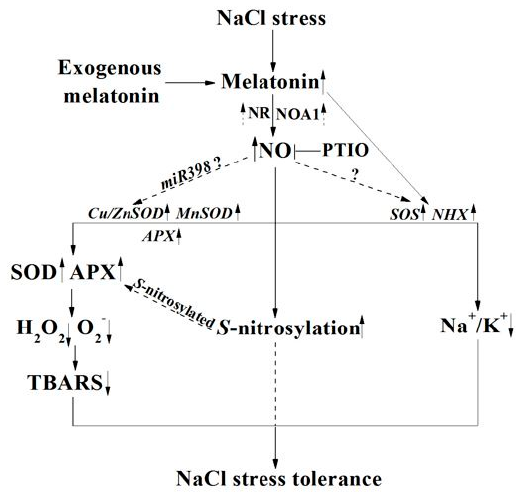
Figure 14. A model depicting the requirement of NR- and NOA1-dependent NO in melatonin-enhanced tolerance against salinity. The reestablishment of redox and ion homeostasis was involved. Dashed lines denote indirect or still undescribed pathways, including miRNA398 -modulated gene expression [65] and S -nitrosylated antioxidant enzymes (APX, [48]).